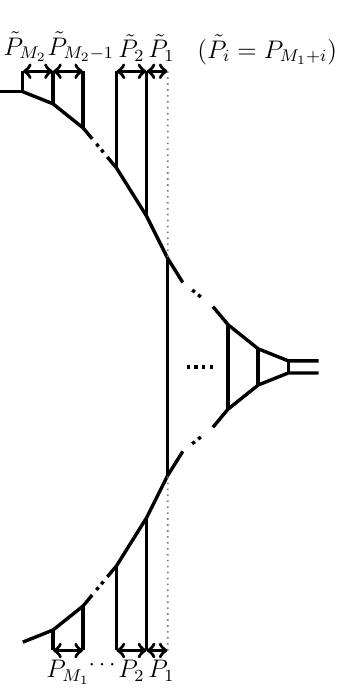
Figure 8 . The assignment of the newly introduced K(cid:127)ahler parameters the web diagram of the b D M 1 ;M 2